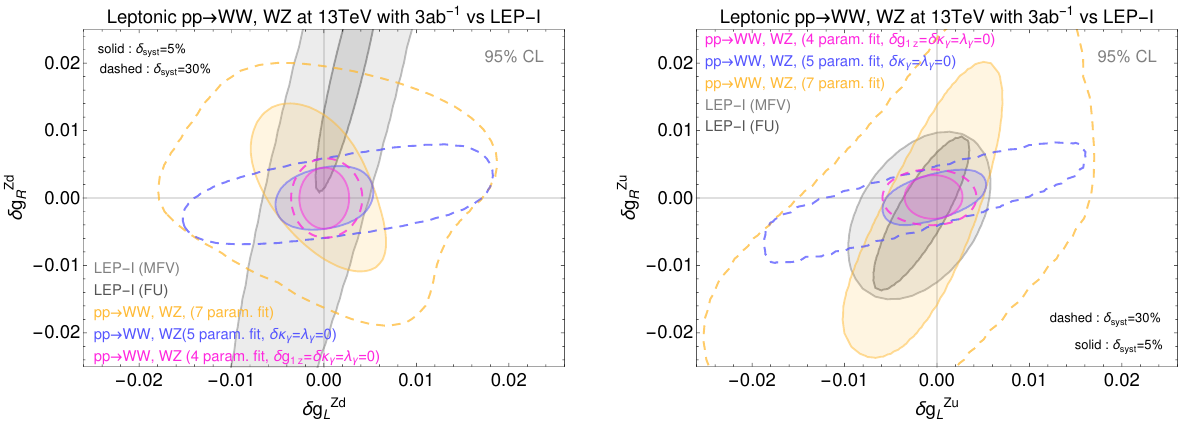
Figure 6 . Estimated 95% CL bounds at HL-LHC on the anomalous couplings between the light quarks and the electroweak bosons. In yellow, diboson bounds after pro(cid:12)ling over the remaining (cid:12)ve parameters. In blue (pink), same but setting also (cid:14)(cid:20) (cid:13) = (cid:21) (cid:13) = 0 ( (cid:14)(cid:20) (cid:13) = (cid:21) (cid:13) = (cid:14)g 1 z = 0). Solid and dashed stand for an assumed (cid:14) syst = 5% and (cid:14) syst = 30% respectively. Light (dark) gray regions correspond to the LEP-1 bounds assuming MFV